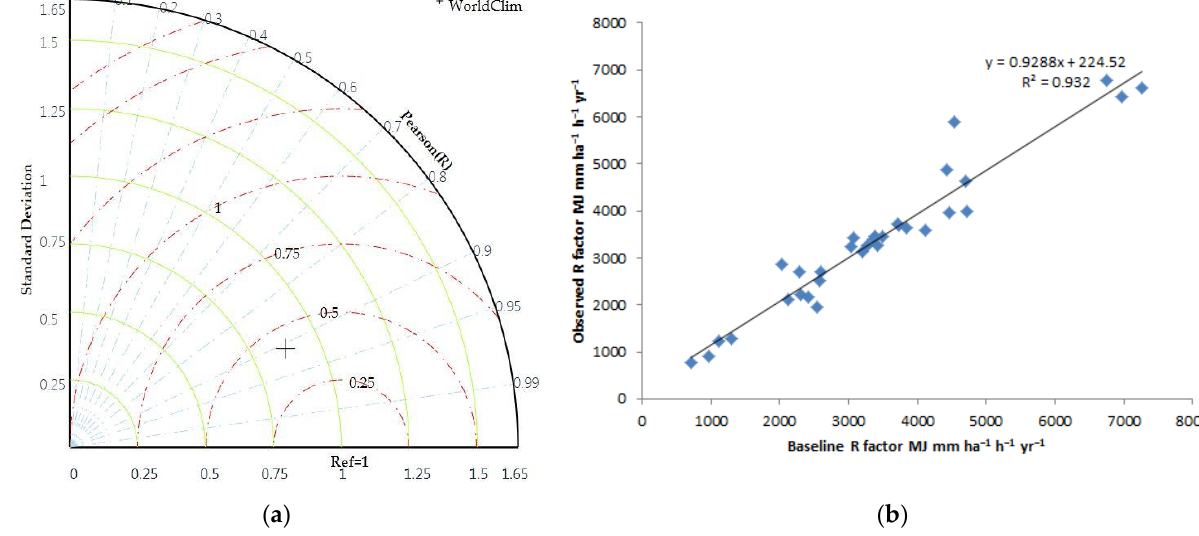
Figure 7. Model validation: ( a ) Taylor diagram for precipitation data; ( b ) Scatter plot between observed and baseline rainfall erosivity.